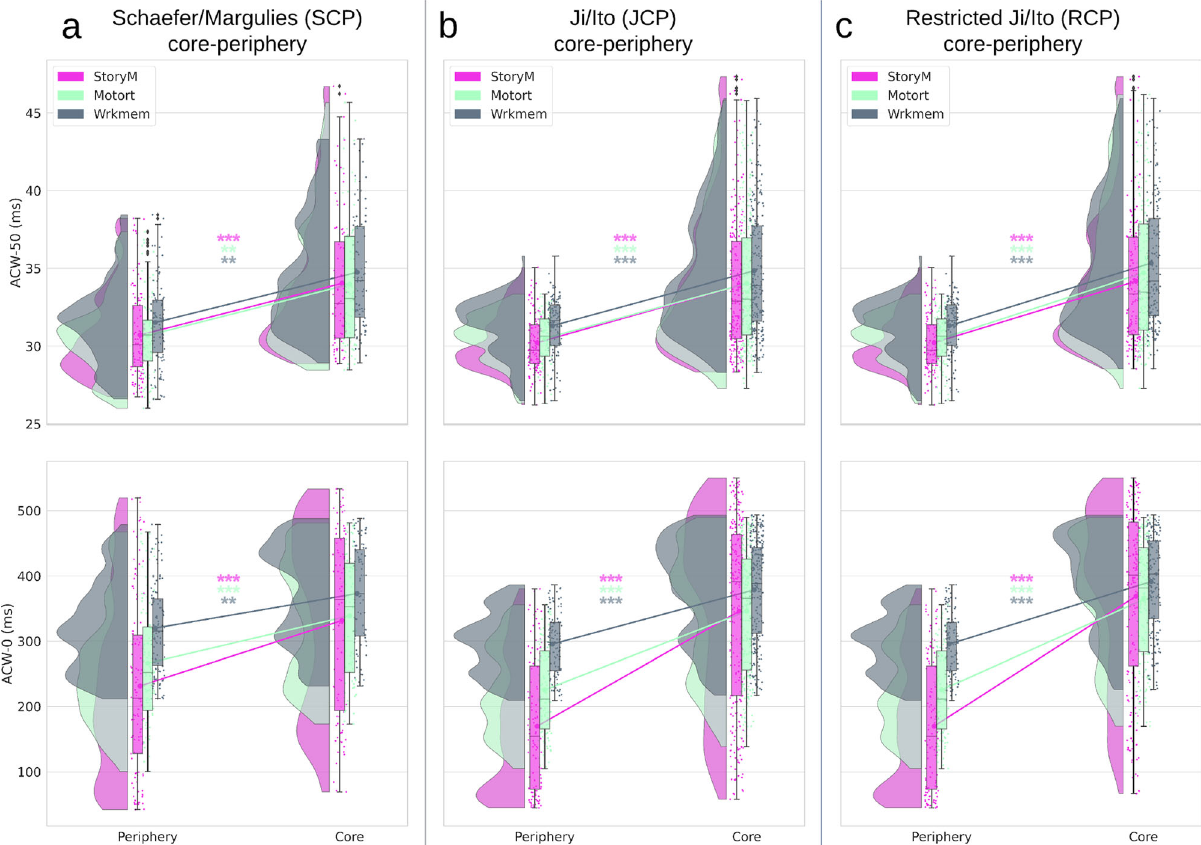
Fig. 4 ACW during task conditions for different core – periphery divisions. Rainclouds represent regions divided into core and periphery. Values are presented in milliseconds. a Showing rainclouds for the ACW values of core and periphery using the Schaefer/Margulies division (SCP). Two-way analysis of variance (ANOVA) using task condition (3 levels: StoryM, Motort and Wrkmem) and CP (2 levels: core and periphery) as factors showed signi fi cant ( p < 0.001) effect of CP factor on ACW-50 ( F (1,594) = 57.69, η 2 = 0.08) and ACW-0 ( F (1,594) = 70.47, η 2 = 0.09). Complete ANOVA result is presented in Supplementary Table 1. b Similar analysis as in ( a ) for the Ji/Ito core-periphery (JCP). Again, two-way ANOVA showed signi fi cant ( p < 0.001) effect of CP factor on ACW-50 ( F (1,1074) = 318.44, η 2 = 0.22) and ACW-0 ( F (1,1074) = 464.40, η 2 = 0.26). c Similar to ( a ) and ( b ) but using the